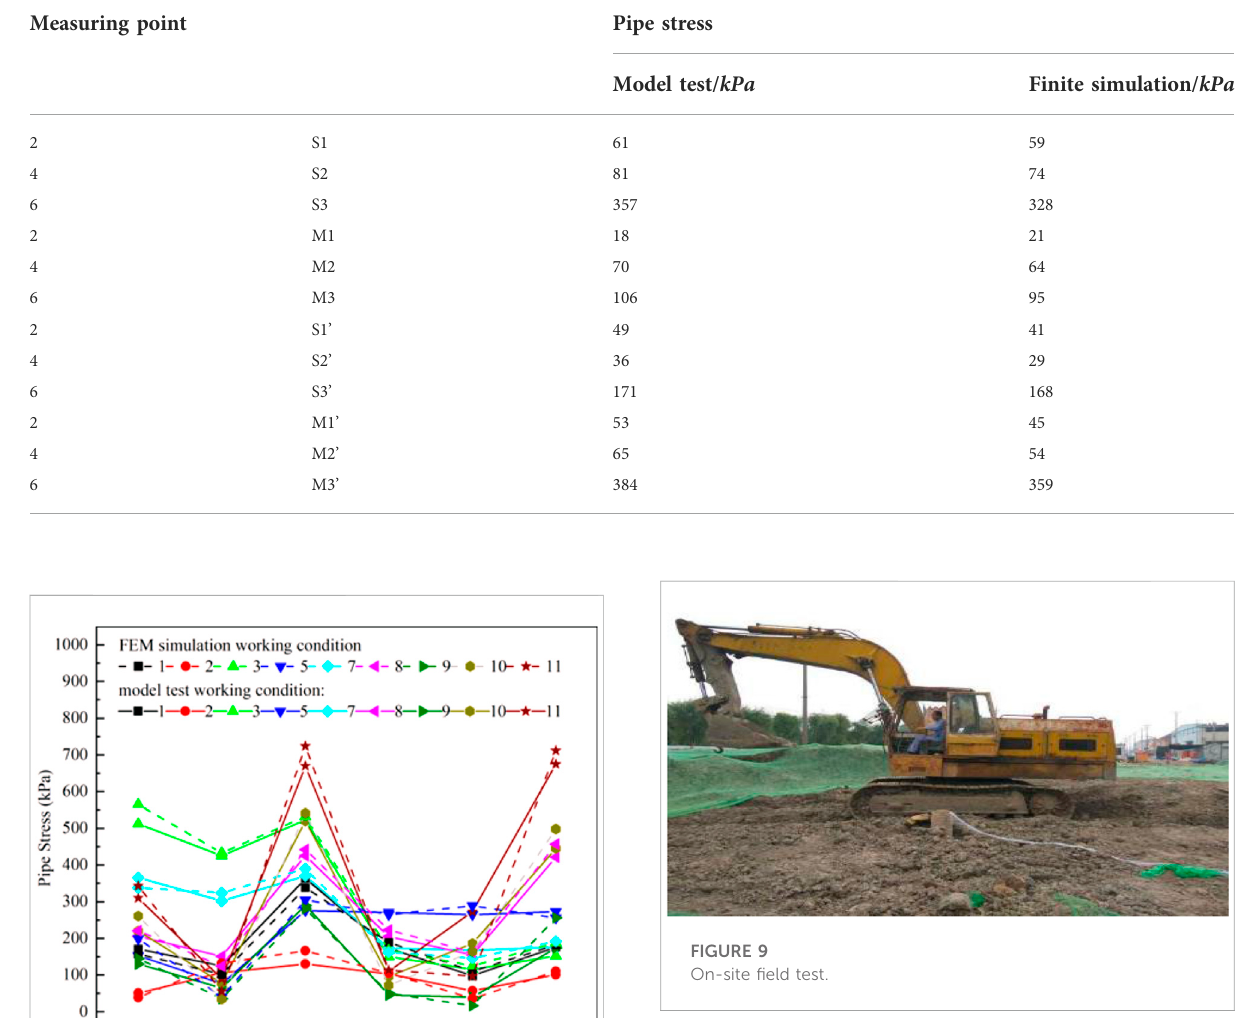
TABLE 3 Finite simulation and measured values.